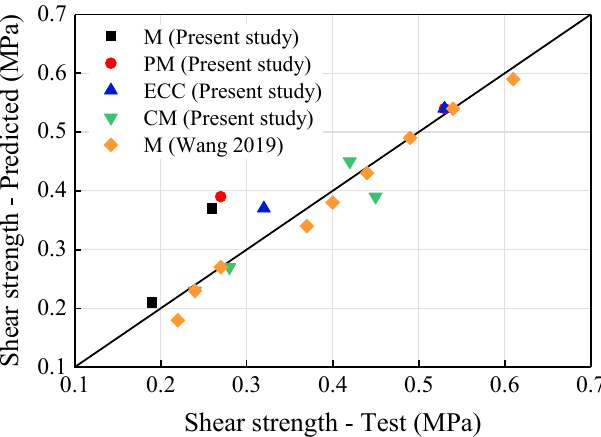
Figure 21. Comparison of the shear strength between the predicted results and the test data.